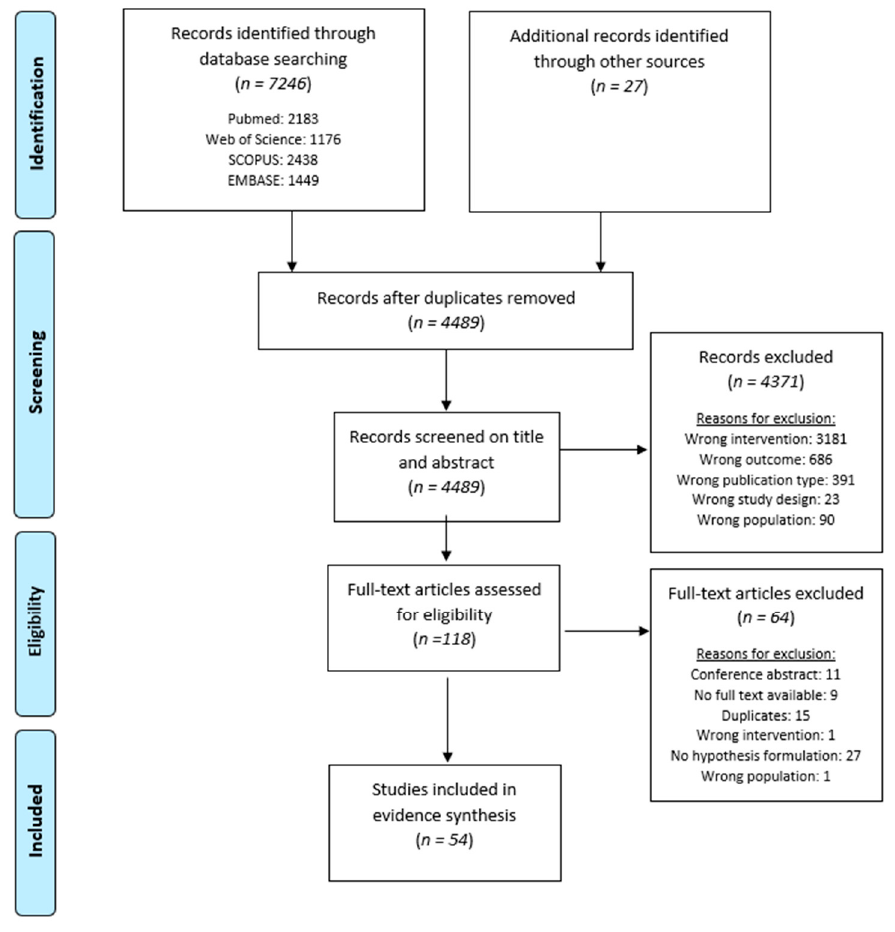
Figure 1. Flowchart of the systematic review. This figure shows the complete flowchart of the search and screening of articles for this systematic review. Abbreviations. n : number of studies.